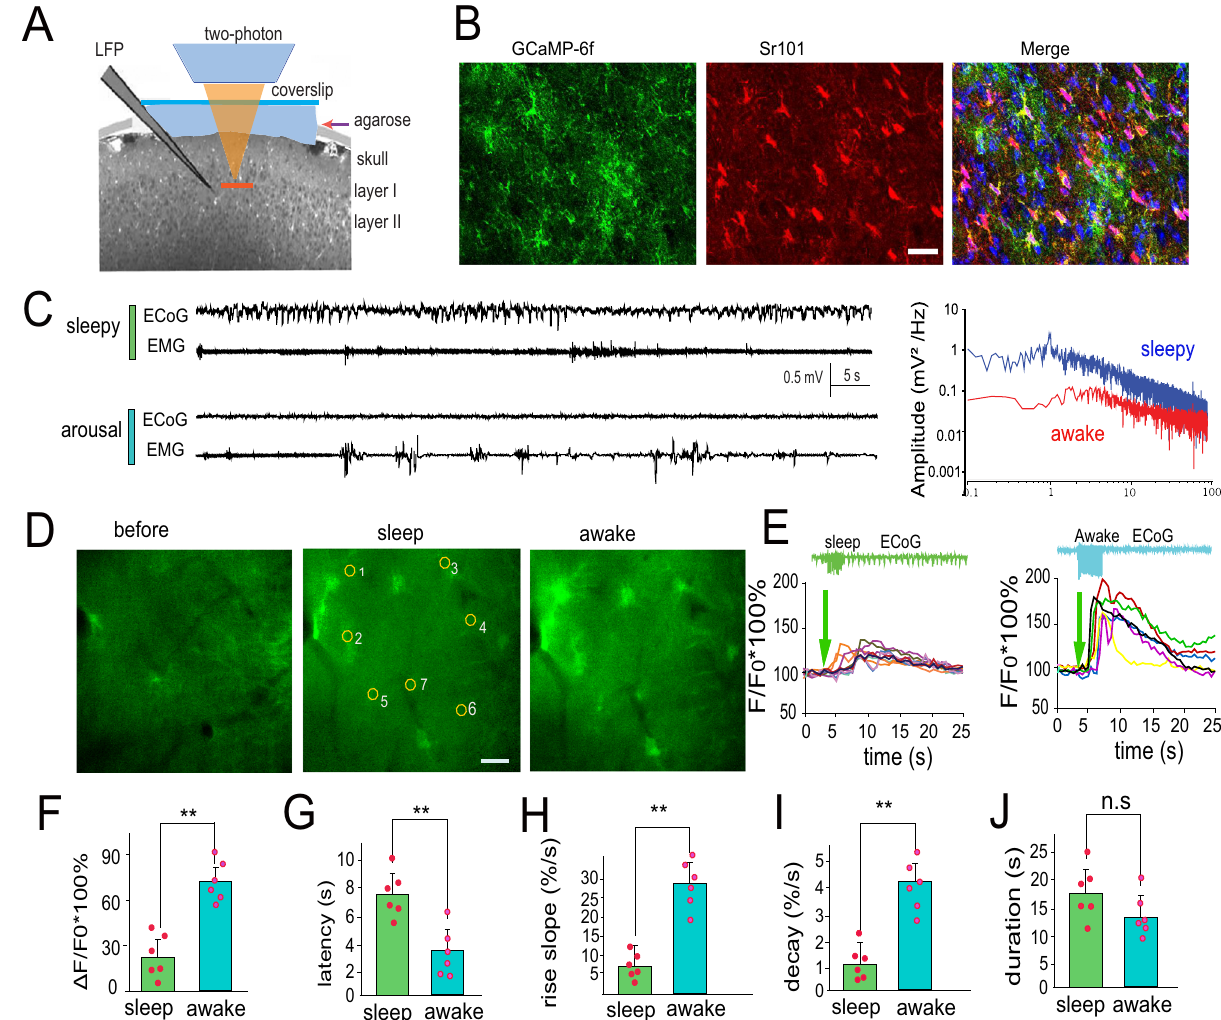
Fig.1|TwodistinctCa 2+ wavesatastrocytic fi neprocessesarecharacterizedfor the sleep and awake states. A A schematic drawing depicting the experimental setup combining two-photon imaging of astrocytic Ca 2+ signaling in the barrel cortex with in vivo whole-cell recordings in single neurons and local fi eld record- ings in awake behaving GCaMP6f transgenic mice. B Representative fl uorescence photomicrographs of the barrel cortex displaying the expression of GCaMP6f (left panel), SR101-loaded astrocytes (middle panel), and merged images (right panel) illustrating that some of the GCaMP6f-expressing astrocytes were colabeled with SR101-loadedastrocytes.Scalebar=10 µ m. C RepresentativerecordingsofEEGand EMG and power spectrum analyses during sleep and in awake mice (blue as sleep; red as arousal). Upper traces are representative ECoG traces from whisker stimu- lation. Awakestates wereshownasno apparentevoked ECoG response and strong